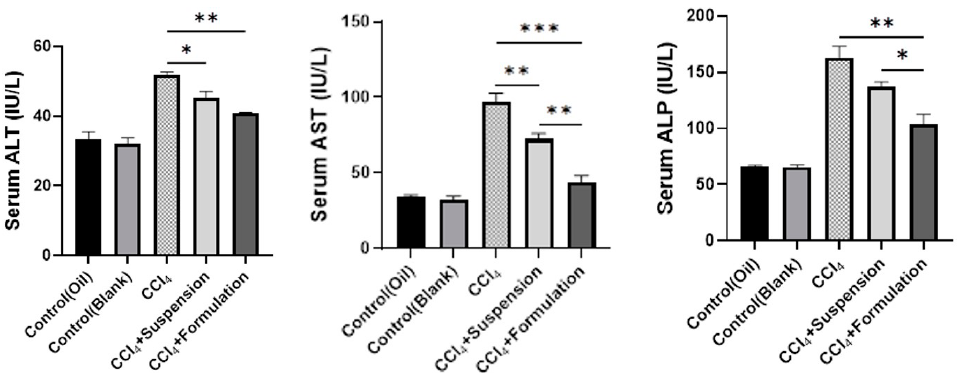
Figure 6. Effect of B. lacera leaf extract and its liposomal preparation on liver biomarker levels. Data are presented as mean ± SEM, n = 6. where * p ≤ 0.05, ** p ≤ 0.01, *** p ≤ 0.001, when compared between the CCl 4 , CCl 4 + suspension and CCl 4 + formulation (liposomal) groups. p ≤ 0.05 was considered statistical level of significance for all cases.